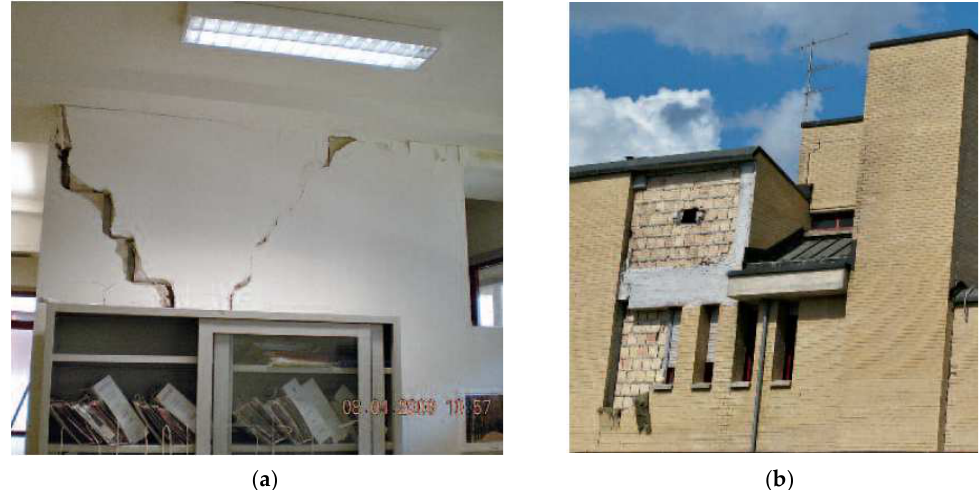
Figure 1. Examples of nonstructural damage detected in the San Salvatore hospital in L’Aquila after the 2009 event (pictures from [7]): ( a ) damage to internal partitions; ( b ) collapse of masonry veneers outside one of the hospital buildings.